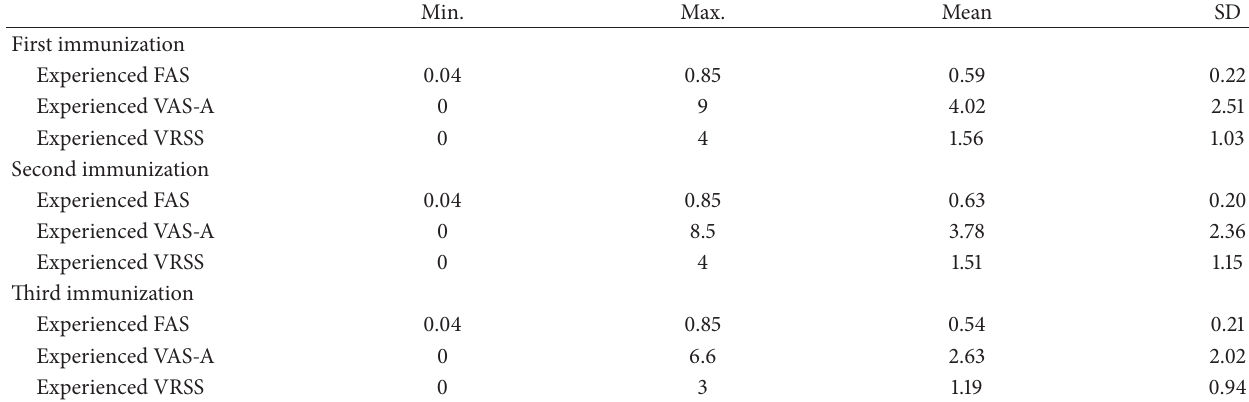
Table 3: Descriptive statistics.